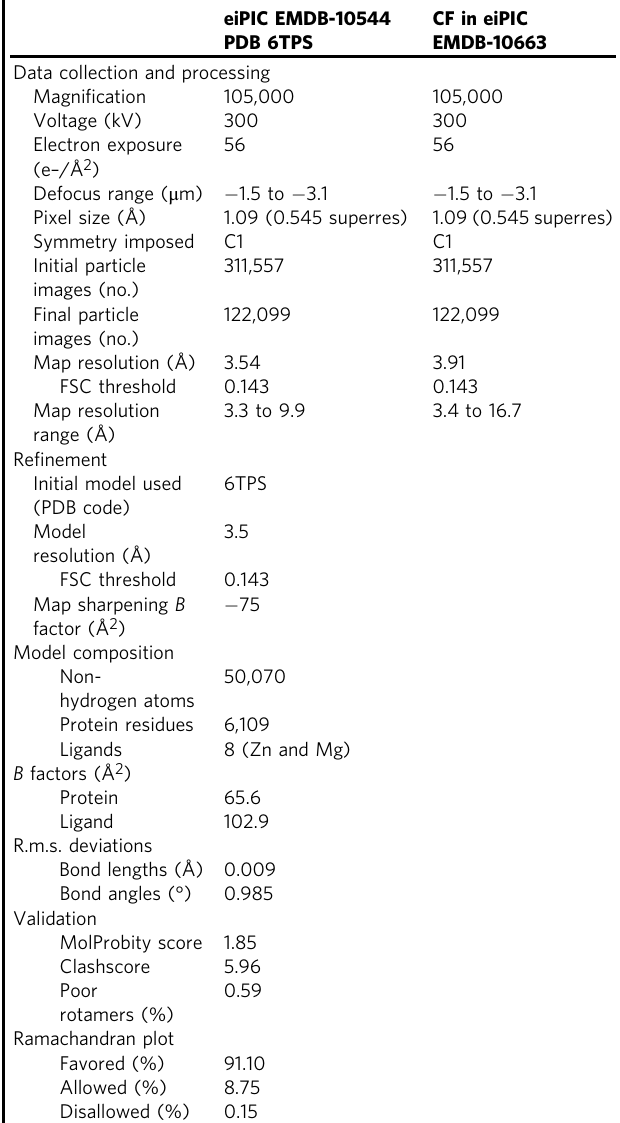
Table 1 Cryo-EM data collection, re fi nement, and validation